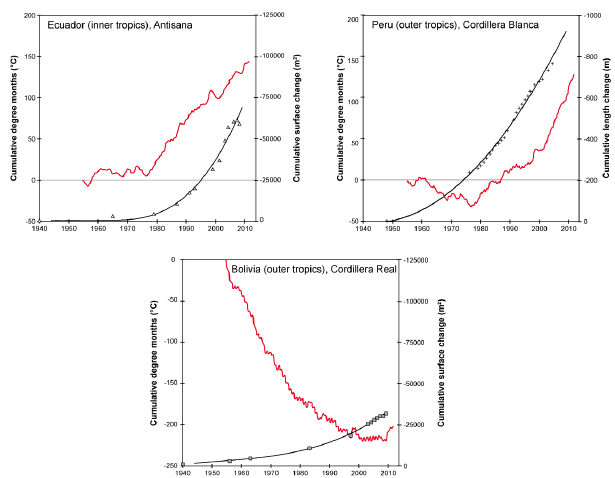
Fig. 11. Cumulative degree months (NCEP/NCAR temperature re- analysis data) at glacier snouts for the 1955–2011 period (red line) at three locations: Antisana in Ecuador, Cordillera Blanca in Peru, and Cordillera Real in Bolivia. For each zone, the symbols repre- sent the cumulative glacier change in terms of surface (average of the available data in Ecuador and Bolivia) or length (average of the available data in Peru). The regression line associated with the sym- bols match a 3rd order polynomial